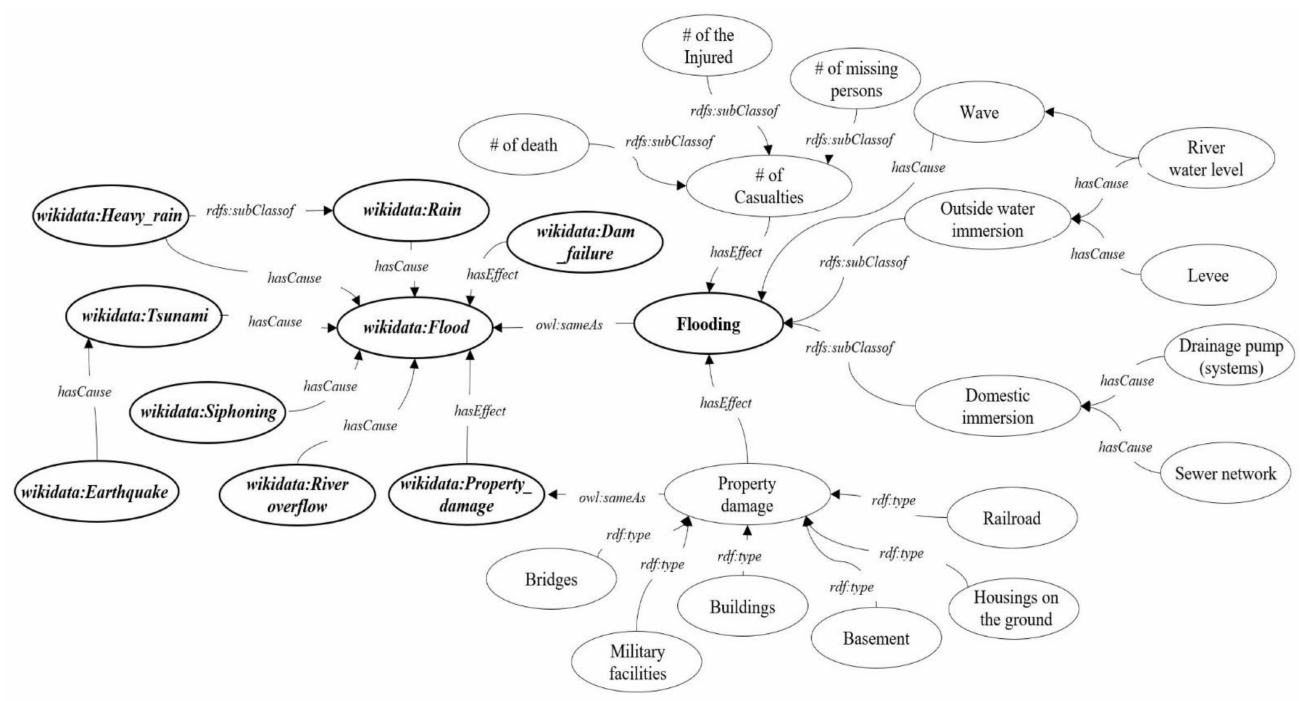
Figure 3. Principal knowledge graph with Flooding based on the open